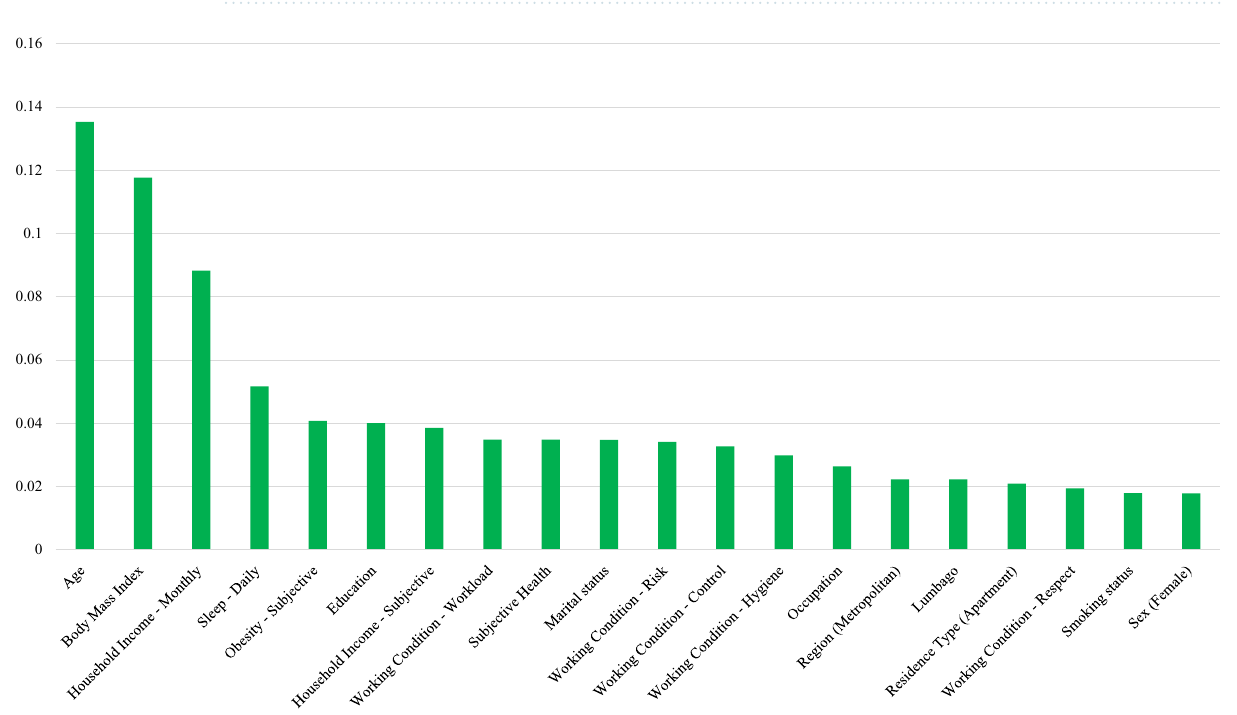
Figure 2. The results of variable importance from the random forest, the top 20 determinants of TMDs as diagnosed by a doctor: body mass index, age, household income (monthly), sleep (daily), obesity (subjective), working condition (control, hygiene, respect, risks, and workload), household income (subjective), subjective health, education, occupation, smoking status, residence type (apartment), region (metropolitan), sex, marital status, and allergic rhinitis.